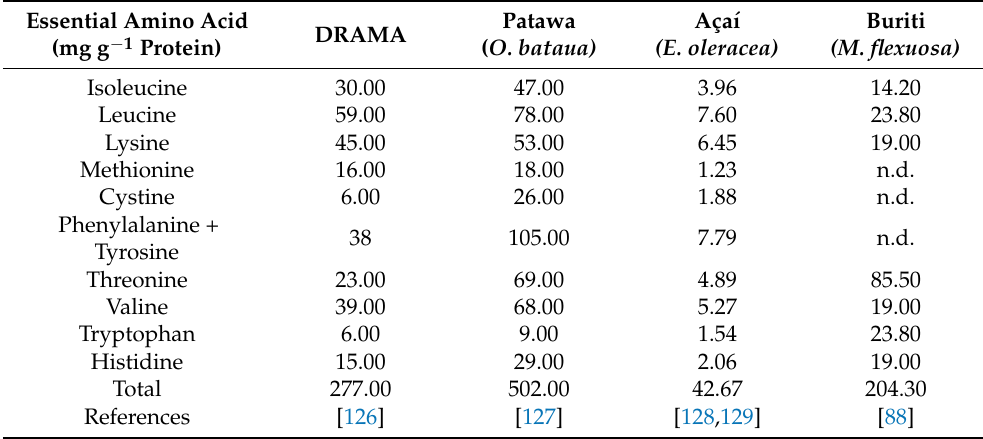
Table 3. Essential amino acid in fruits belonging to the Arecaceae family and daily requirement of amino acids (DRAMA) for